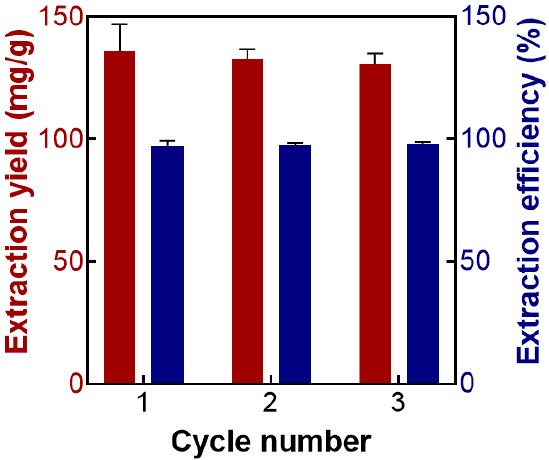
Figure 5. The extraction yield ( Y , mg/g) and extraction efficiency (%) of AMP in the recycling tests.